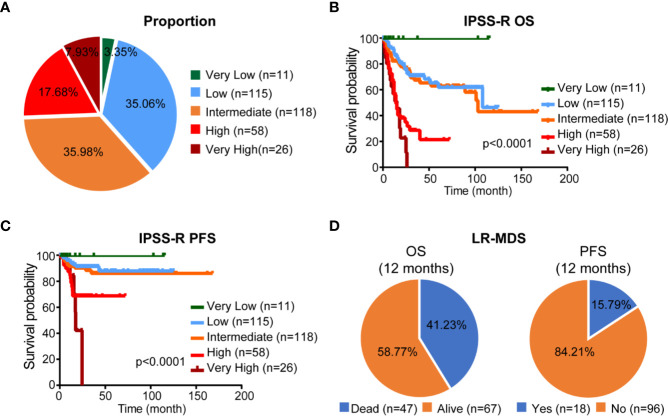
Proportion and prognosis of patients according to IPSS-R classification. (A) Proportion of patients according to IPSS-R classification. (B, C) Kaplan-Meier curves for OS and PFS according to IPSS-R classification. (D) Proportion of different clinical outcome of LR-MDS.